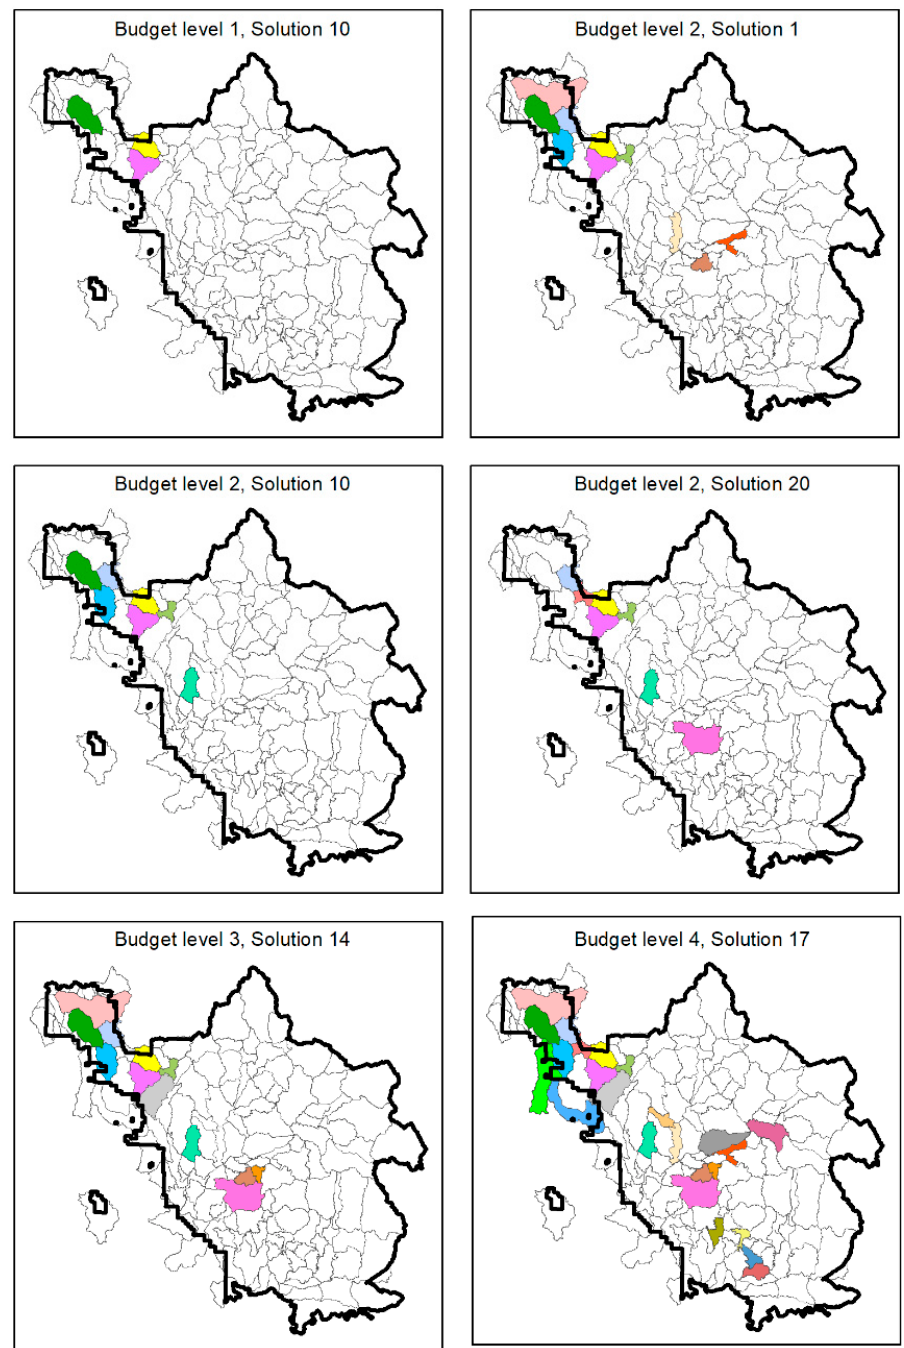
Figure 5. Location of PODs selected for treatment in each of the six fuel treatment scenarios. The colors are unique to each POD, allowing easier viewing and identification of which PODs were selected in multiple treatment scenarios.